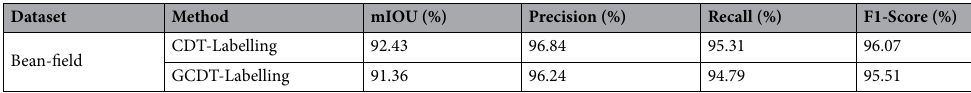
Table 9. The effect of using CDT and GCDT to generate threshold labels for the Bean-Field